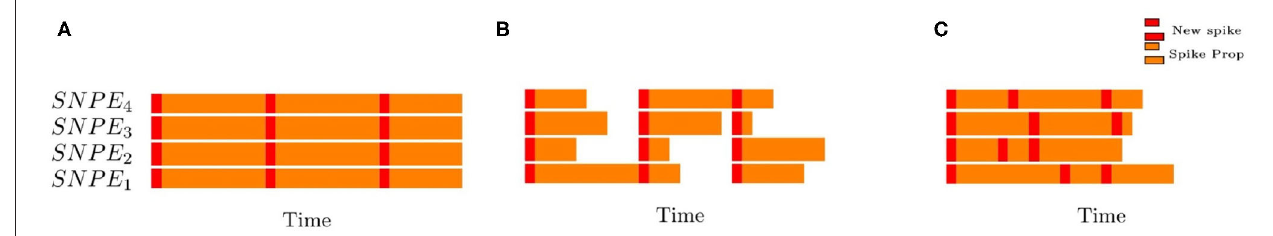
FIGURE 9 | Timing diagrams illustrating the need for asynchronous spike serving for the probabilistic spike propagation. (A) Synchronous SNPE-deterministic spike propagation, (B) Synchronous SNPE-probabilistic spike propagation, (C) Asynchronous SNPE-probabilistic spike propagation.